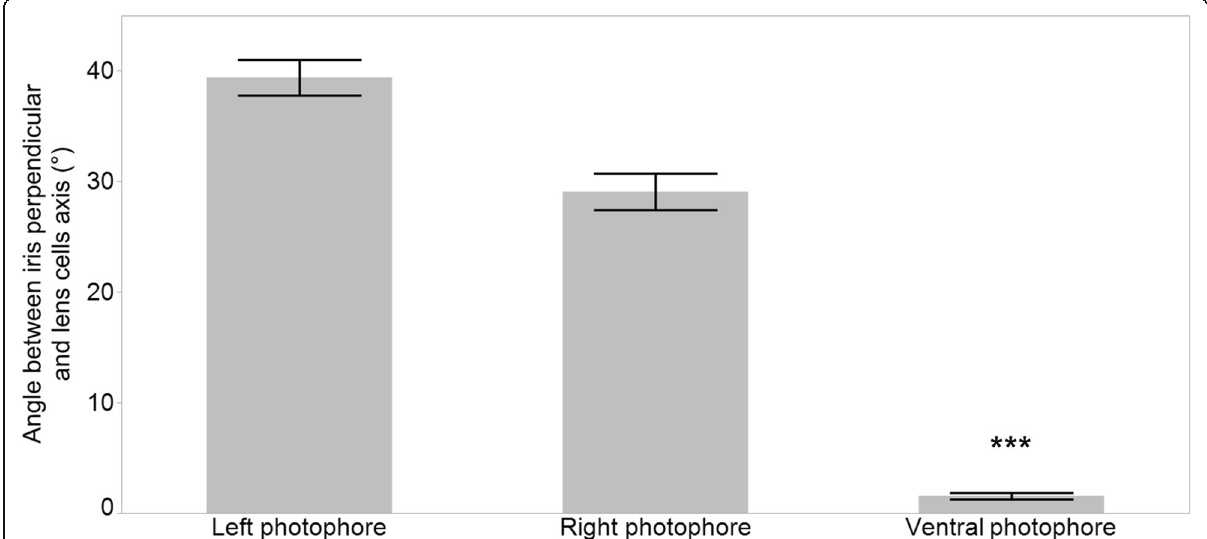
Fig. 4 Mean inclination angle between iris perpendicular and the lens cells axis of left and right spine base associated photophores (SBAPs) and ventral photophores